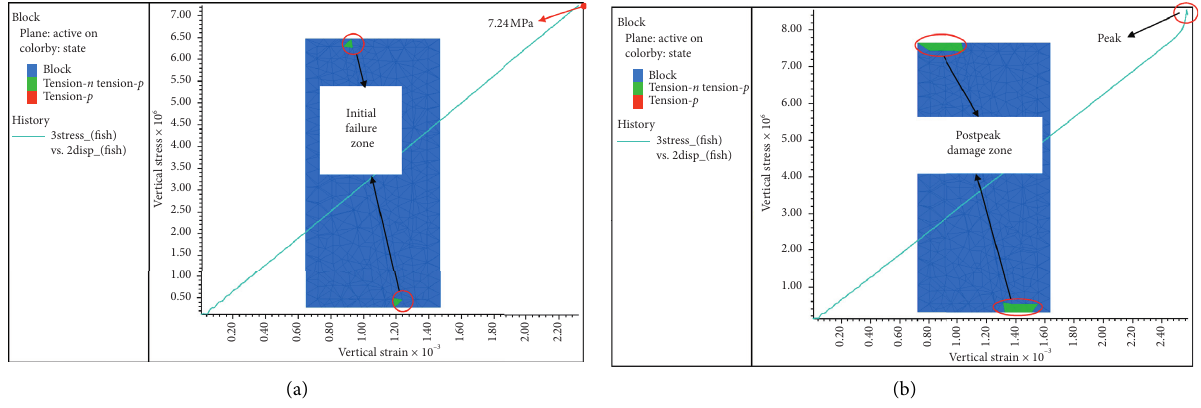
Figure 17: The change position of the specimen block failure. (a) Initial failure. (b) Peak